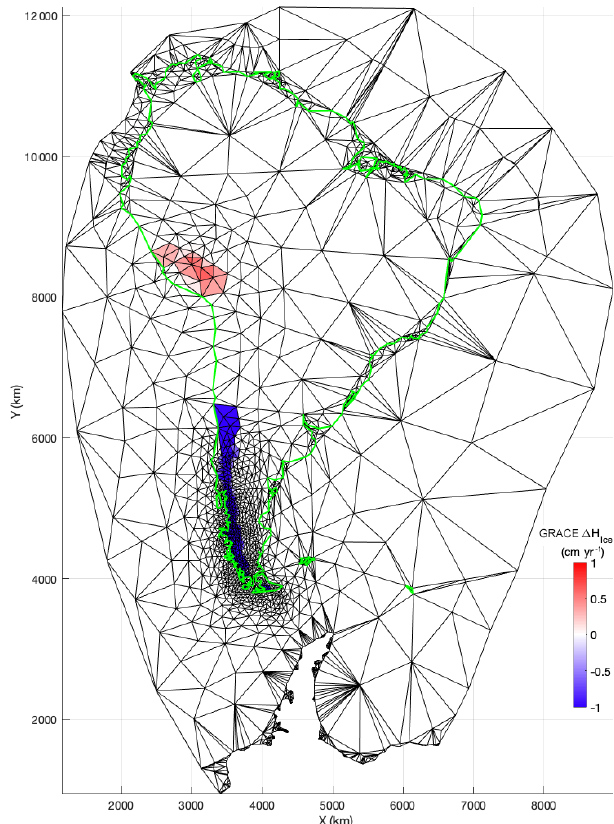
Figure 5. A 2-D adaptive mesh of South America using GRACE ob- servations of ice and hydrological mass change (in cmyr − 1 ) from 2003 to 2016. Seismic effects (Richter et al., 2019) are not removed in this rendering of Patagonian ice mass loss that was directly taken from Adhikari and Ivins (2016). The Global Self-consistent, Hier- archical, High-resolution Geography database (GHSSH) L1 coarse version coastline is shown in green. Segments of the triangular mesh are plotted in black. The color bar for the thickness changes was saturated at [ − 1,1] cmyr − 1 in order to improve the contrast of the figure given the high mesh